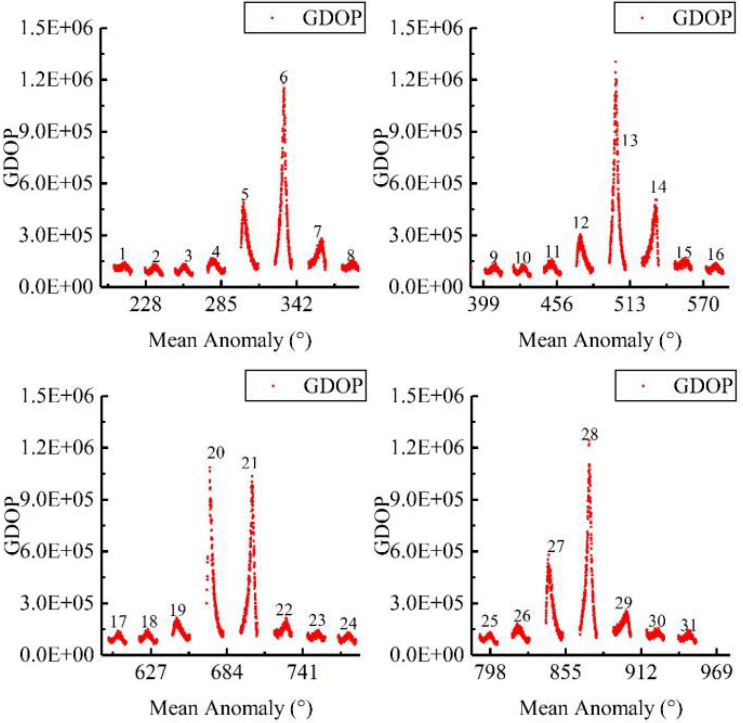
Figure 3. GDOP calculated by Monte Carlo simulations at different visible arc segments.